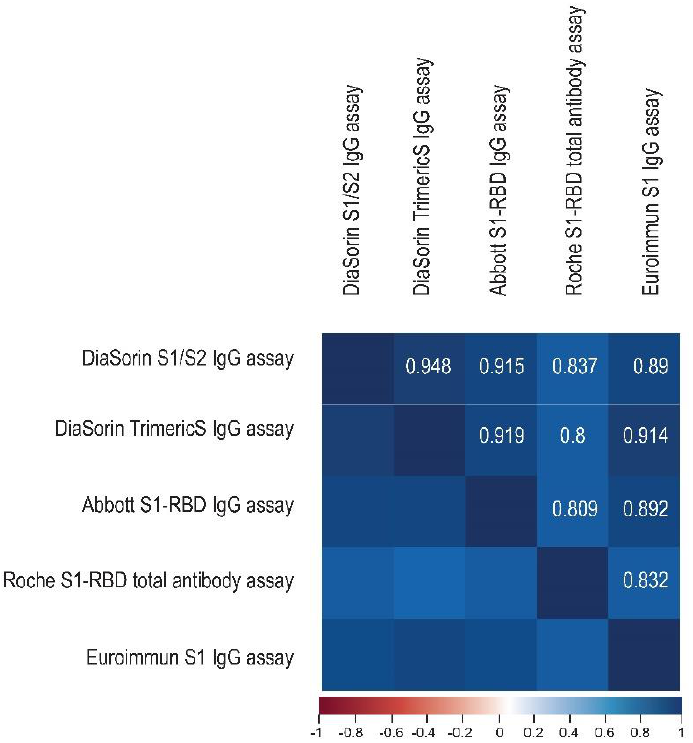
Figure 2. The correlation matrix heatmap shows the values of the Spearman correlation coefficient for the studied immunoassays, with the positive values (r > 0) in blue. The darker the shade of blue, the stronger the positive correlation.